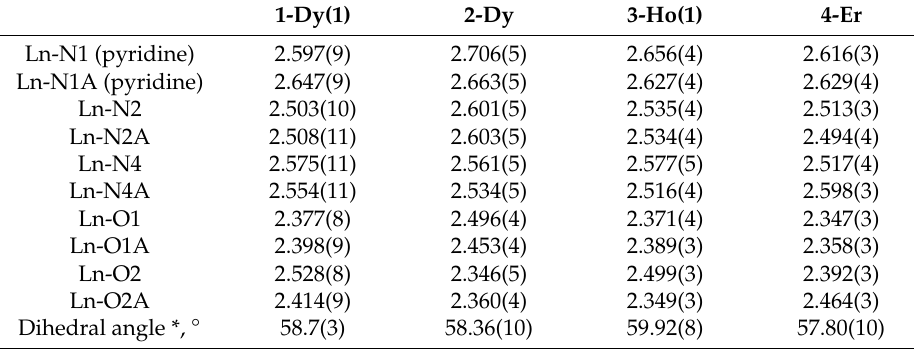
Table 2. Selected bond lengths (Å) and angles ( ◦ ) in 1-Dy(1) , 2-Dy , 3-Ho(1) and 4-Er